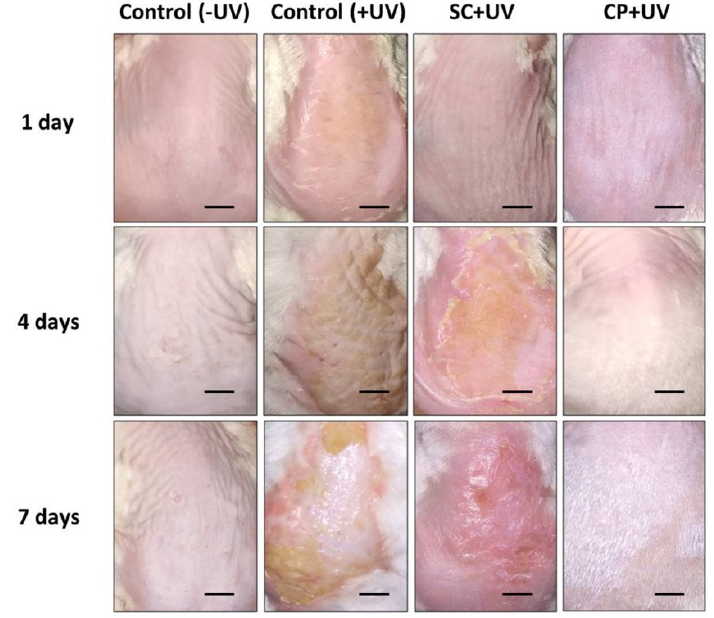
Figure 5. Effect of Sargassum cristaefolium extract (SC) on UV-irradiation skin lesion in mice for seven days. Scale bar: 1 cm.